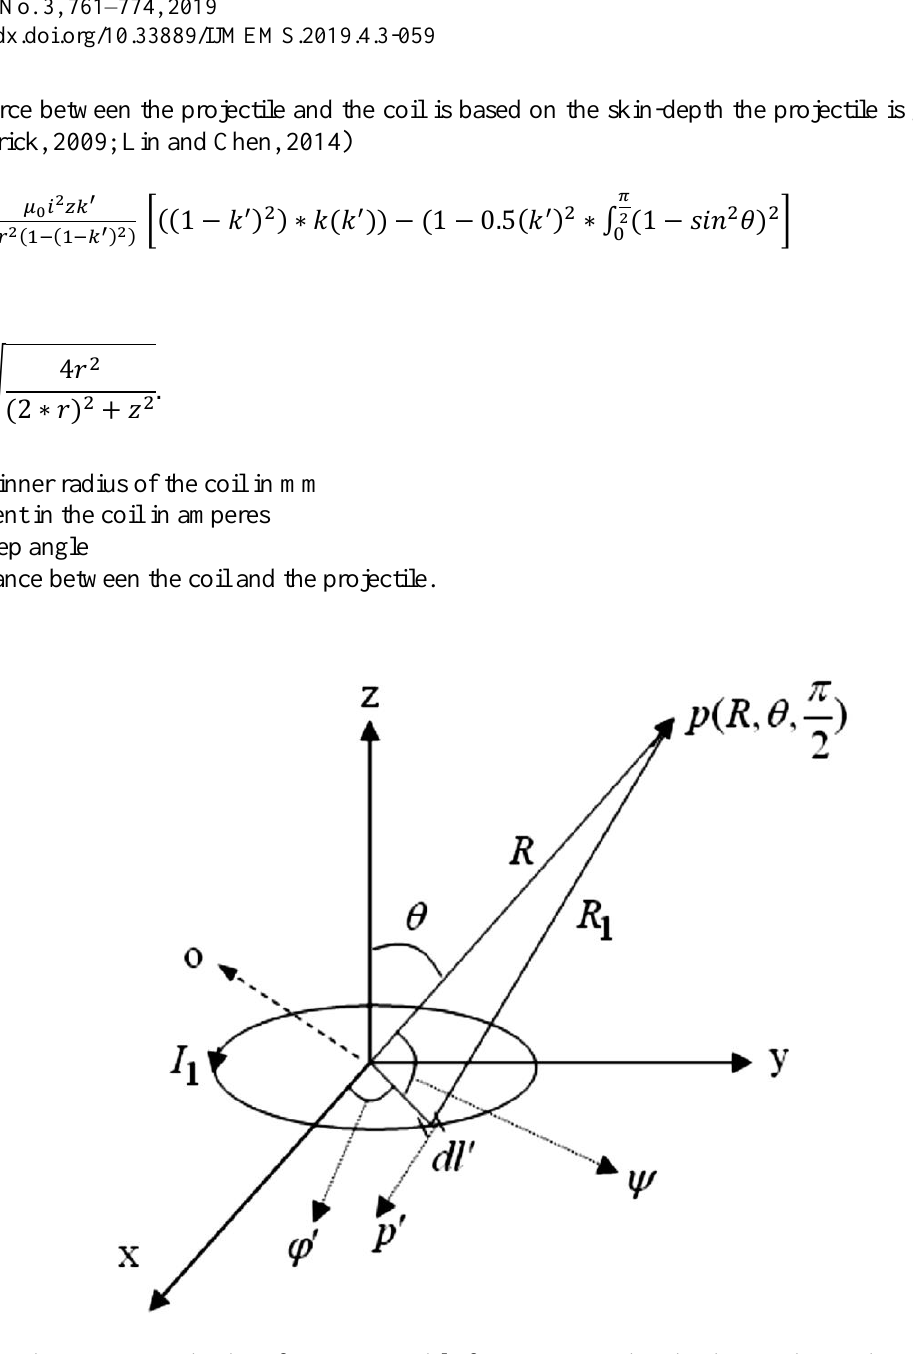
The parameters used in Equation (19) are explained using Figure 6. Sweep angle is the angle between the z-plane of the spiral coil with R (where R is the distance between the origin and the field point P). Su et al. (2009) are referred to derive the formulae for the force. From the above analysis, it is identified that the catapult coil and acceleration coils are having contrasting